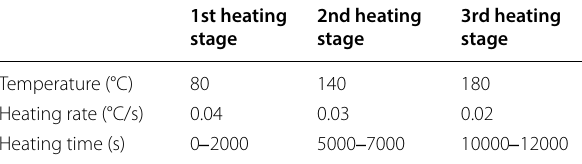
Table 7 Best curing conditions of the pressure